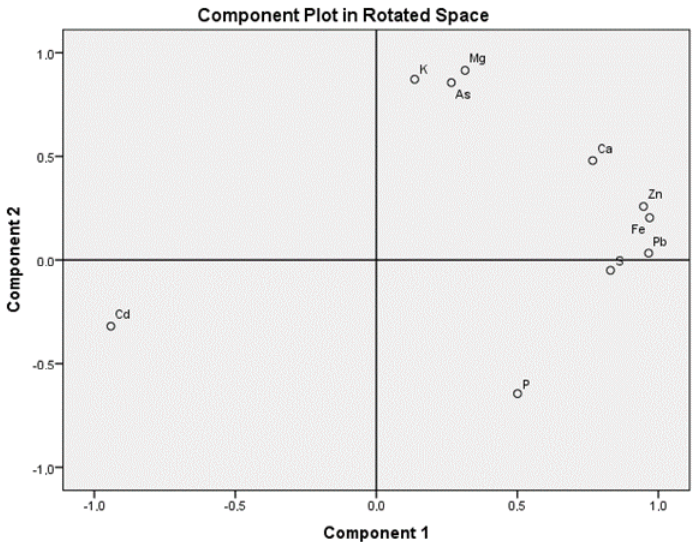
Figure 3. Projection of the factorial plane created with F1 (60.7% variance) and F2 (25.0% variance) axes of the macro and microelements of soil samples (n = 9) of Field B. (Observation: Eigenvalues are greater than 1 only in F1 and F2.)